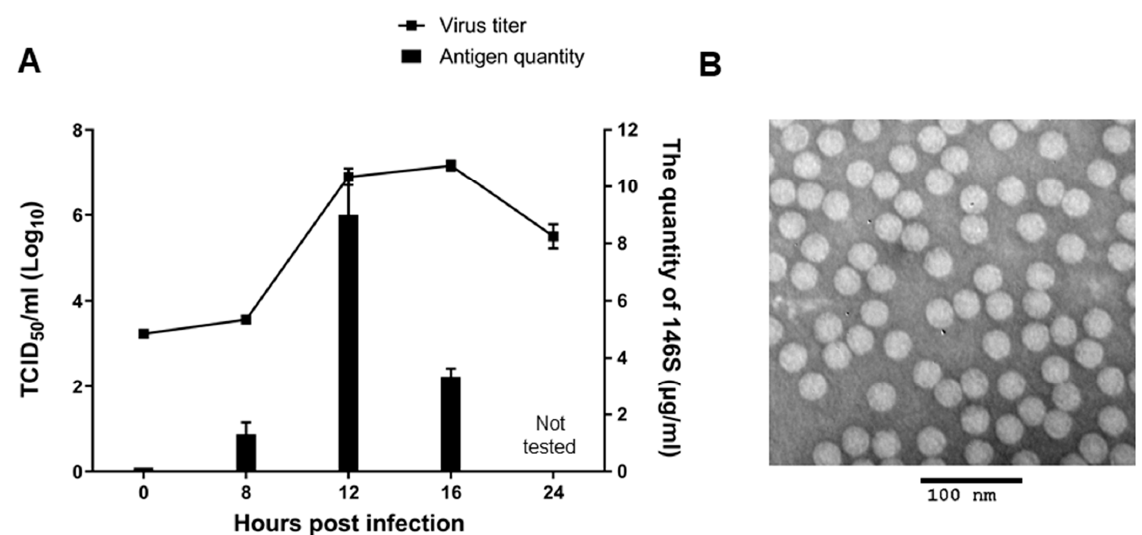
Figure 2. Growth of cell-adapted A/SKR/Yeoncheon/2017 (A-1) and the production of 146S antigen in BHK-21 suspension cells. ( A ) BHK-21 suspension cells were infected with cell-adapted A/SKR/Yeoncheon/2017 (A-1) at a multiplicity of infection of 0.001 and cultured at 37 ◦ C in 5% CO 2 . Supernatants were collected at 0, 8, 12, 16, and 24 h post-infection (hpi) and the TCID 50 was determined (line, left Y -axis). Inactivated antigen (146S) was quantified in the supernatants collected at 8, 12, and 16 hpi by sucrose density gradient centrifugation (bar, right Y -axis). Error bars indicate SDs from the mean. ( B ) Inactivated antigen (146S) from the supernatant collected at 16 hpi was confirmed by transmission electron microscopy.